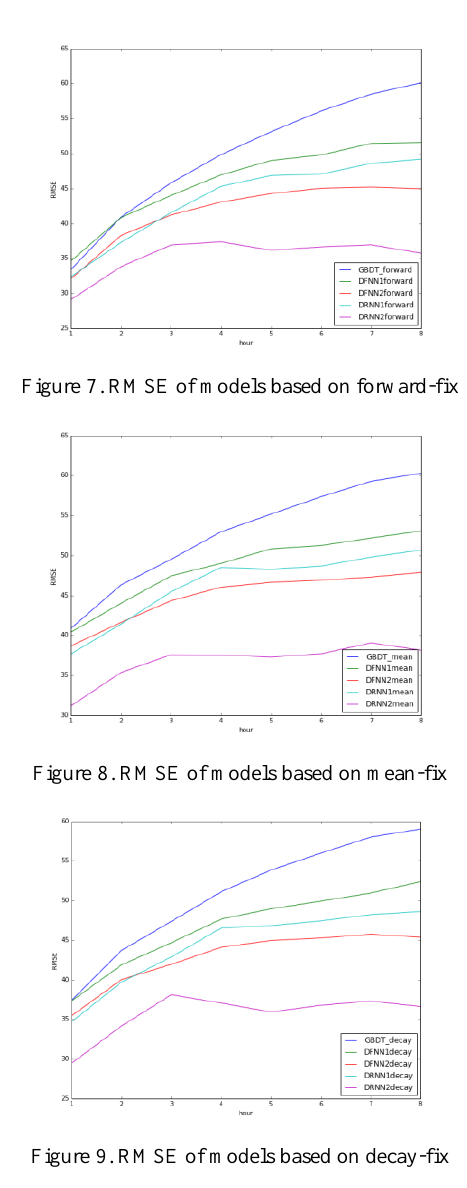
Figure 9. RMSE of models based on